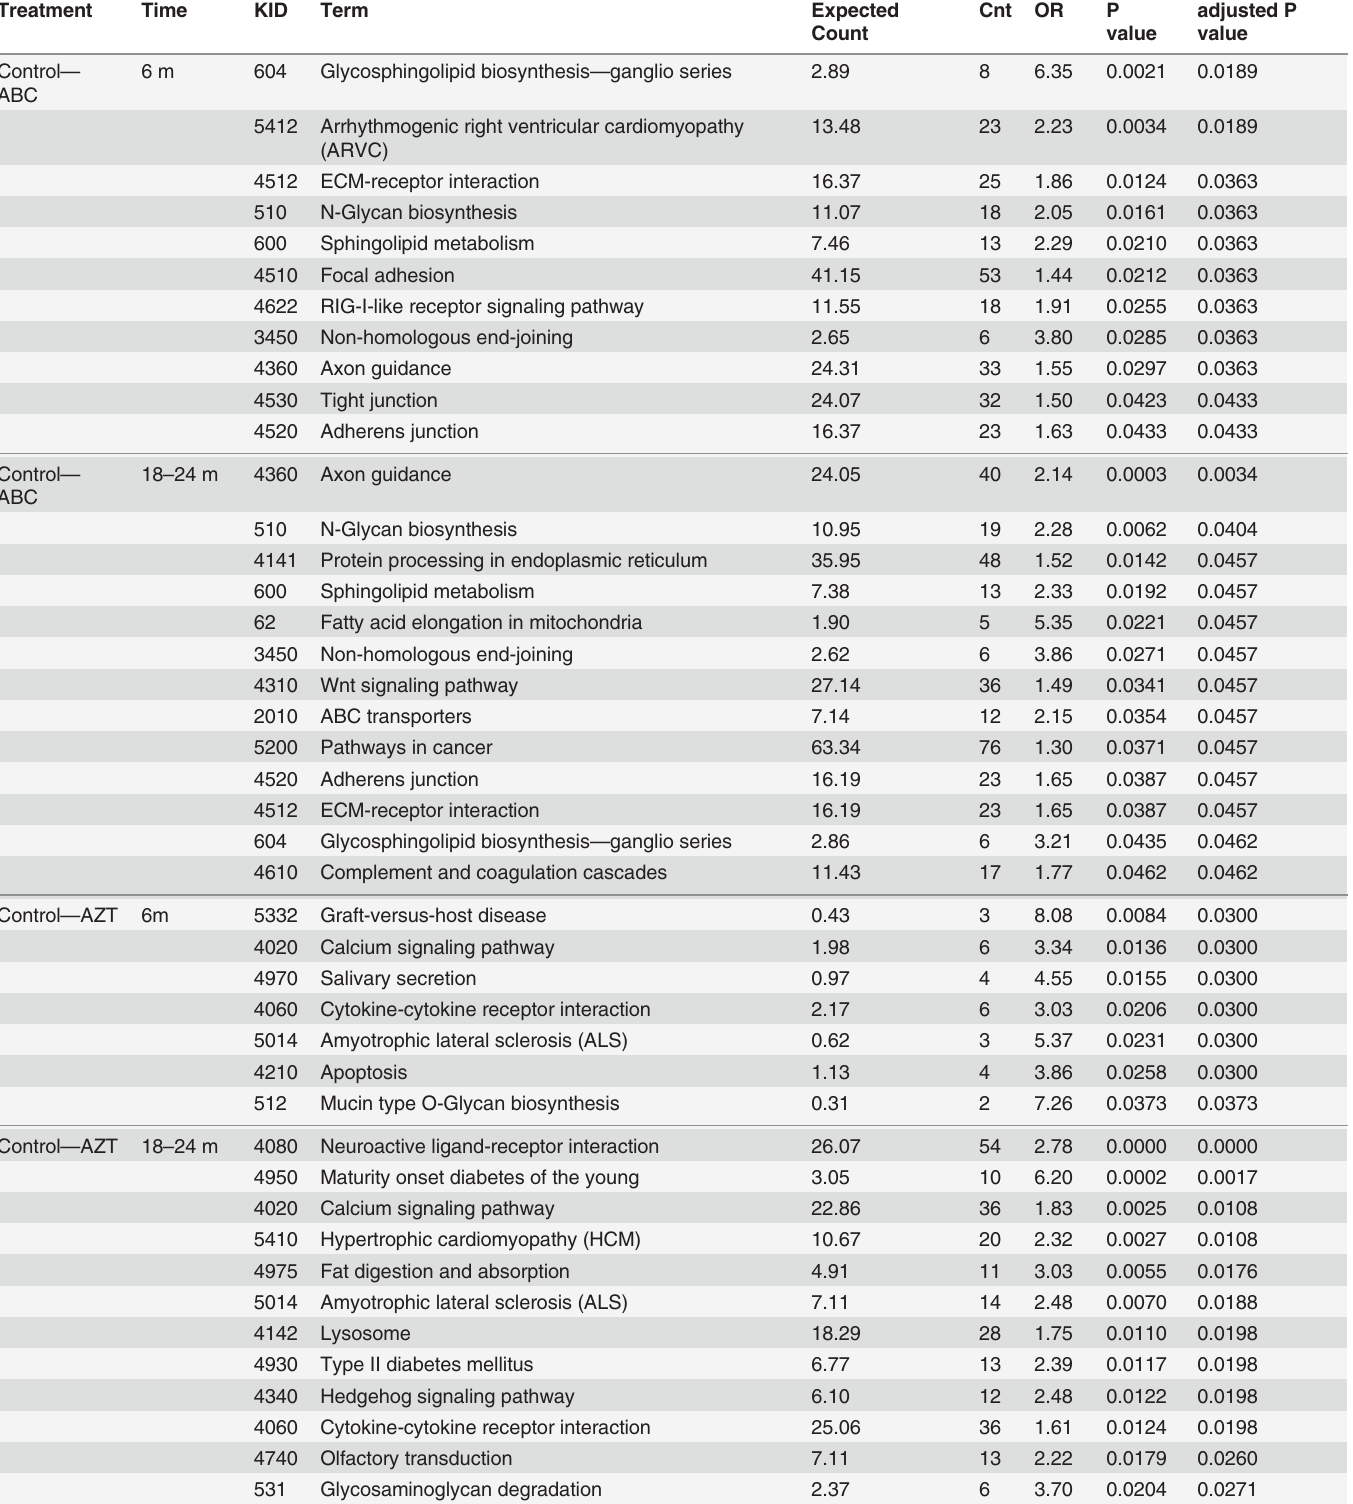
Table 7. KEGG gene pathways signi fi cantly enriched compared to HIV negative controls.